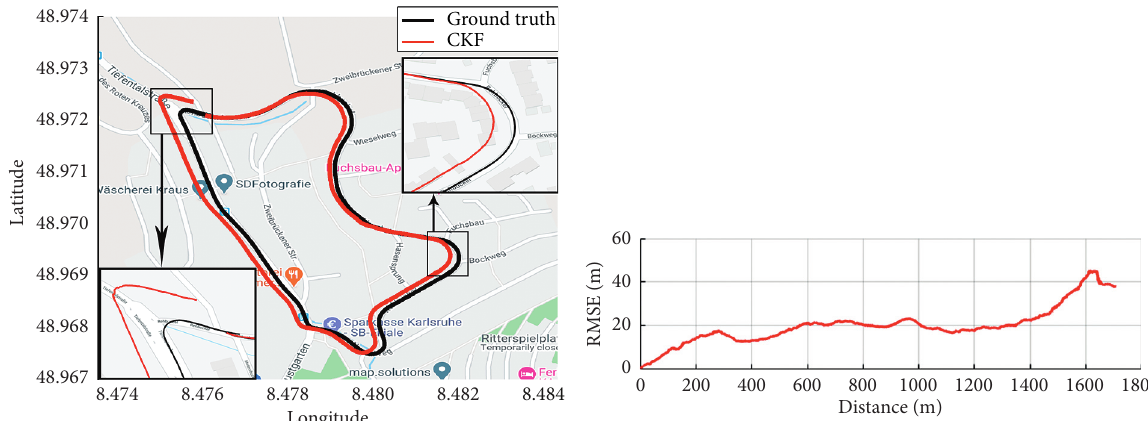
Figure 6: Example of VIO drift in KITTI dataset 2011_09_30_0033.